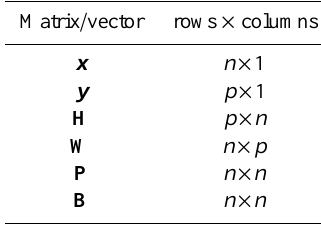
Table 1. Matrices dimensions in the OI algorithm: n (7810) is the grid-points number of the third RAMS domain and p (87) is the number of thermometers. Matrix / vector rows × columns